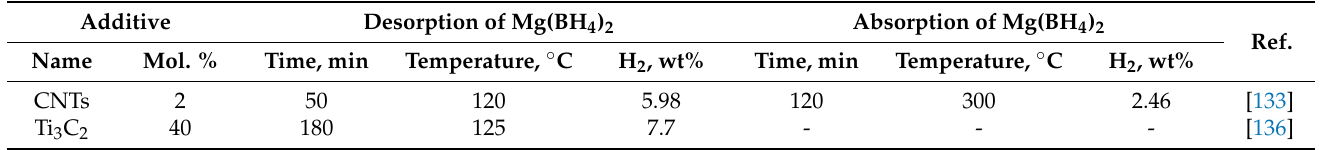
Table 7. Effect of carbon-based additives on the desorption and absorption kinetic of Mg(BH 4 ) 2 .